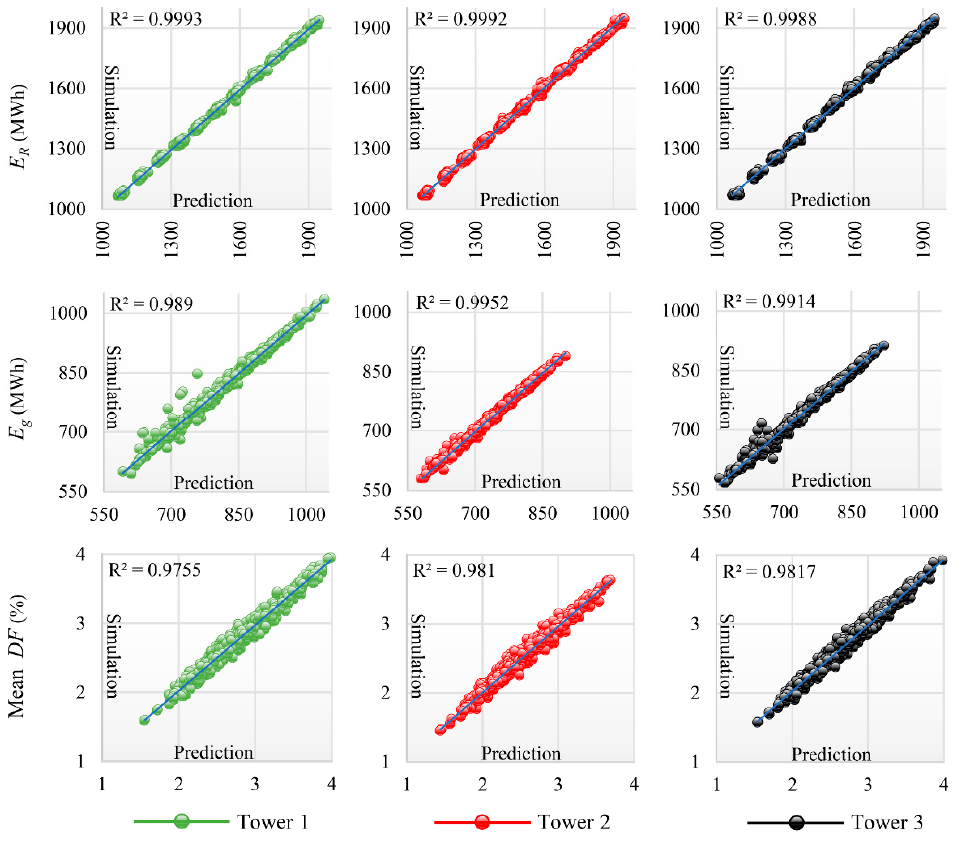
Figure 15. Simulated results versus predicted results.